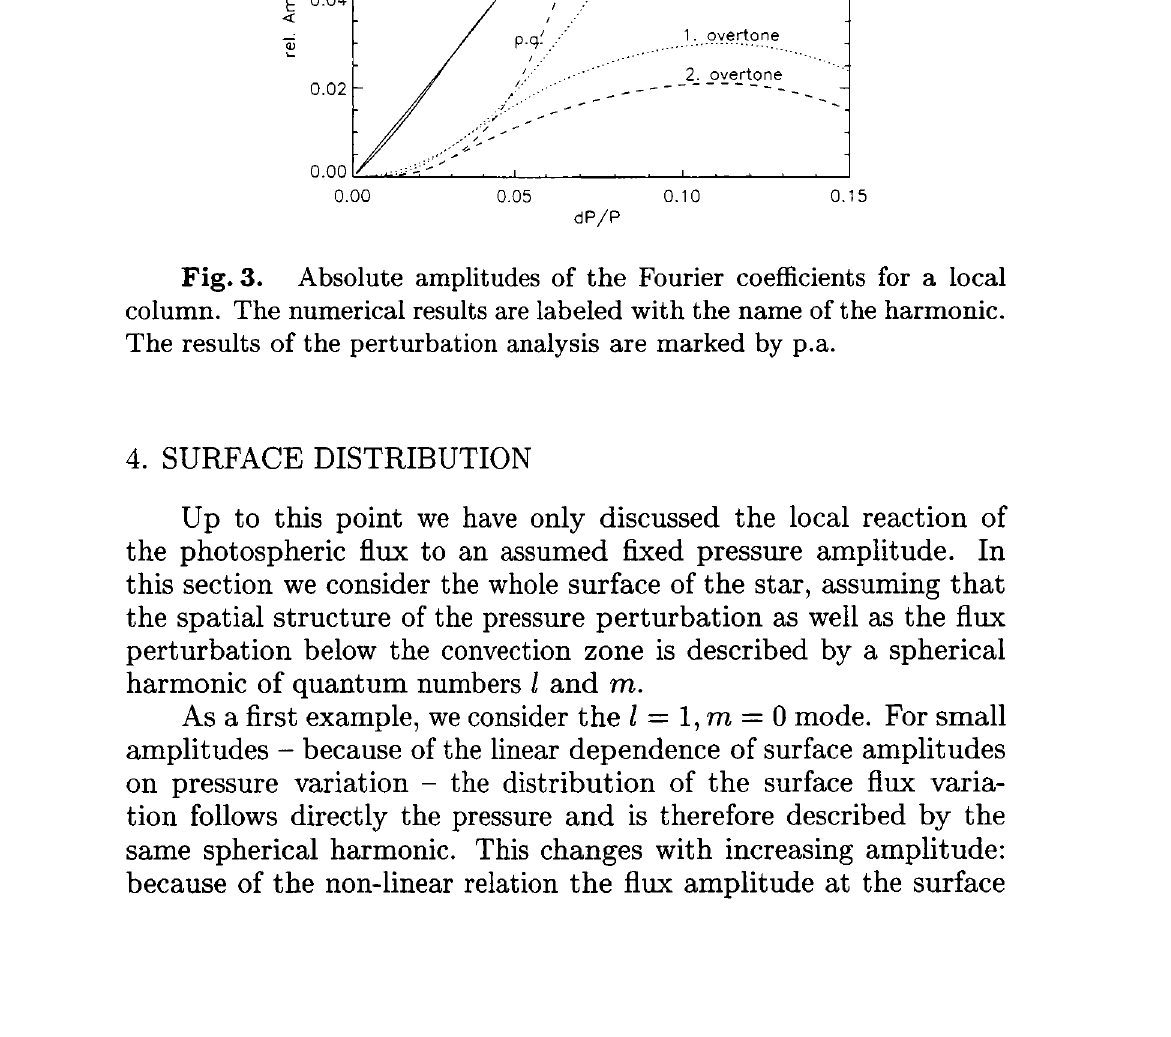
Fig. 3. Absolute amplitudes of the Fourier coefficients for a local column. The numerical results are labeled with the name of the harmonic. The results of the perturbation analysis are marked by